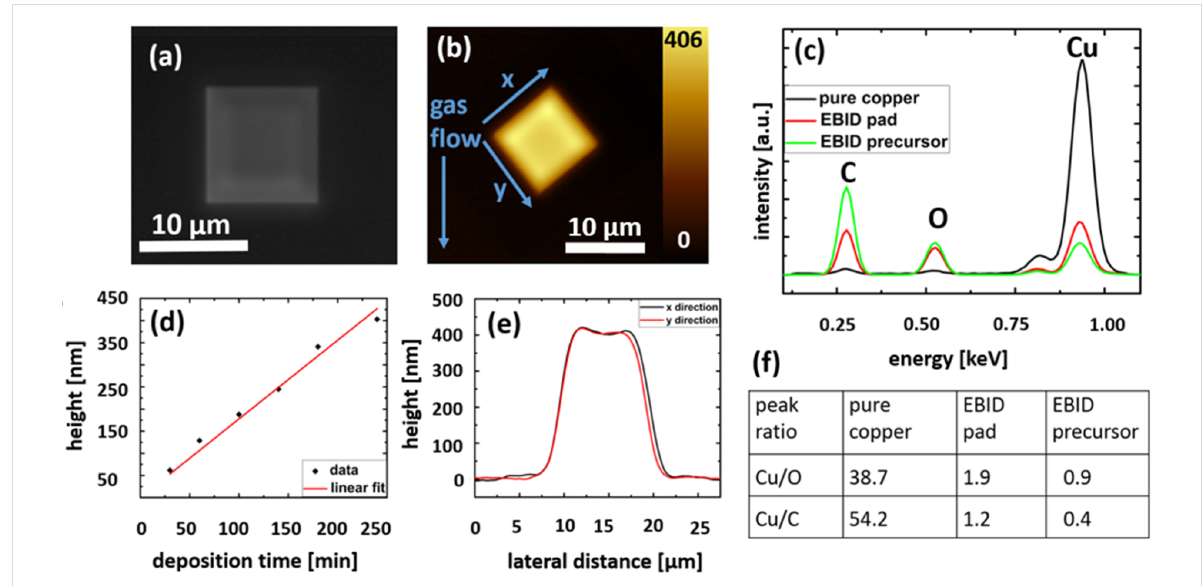
Figure 1: (a) Scanning electron micrograph of a FEBID pad. (b) Atomic force micrograph of the same pad. (c + f) EDX spectra of the solid crystalline precursor, a copper foil with a purity >99.999% and a FEBID pad grown on a silicon substrate with a height above 400 nm. The table shows the peak ratios of copper to oxygen and copper to carbon (d) Height of FEBID pads for different deposition times, written with a dwell time of 10 μ s and a point distance of 3 nm. (e) Atomic force microscope line scans of the FEBID pad in (a) and